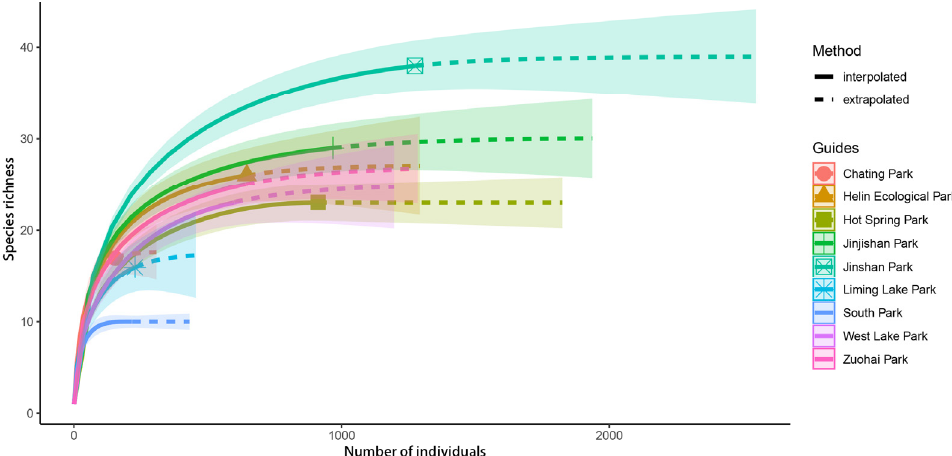
Figure 5. Comparison of individual-based interpolation (rarefaction) and extrapolation of species diversity in different urbanization types of parks under the multinomial model. When the curve tends to be flat, the observed number of species is gradually reasonable and more individuals will only produce fewer new species. Table 1. Bird survey records of 9 urban parks.